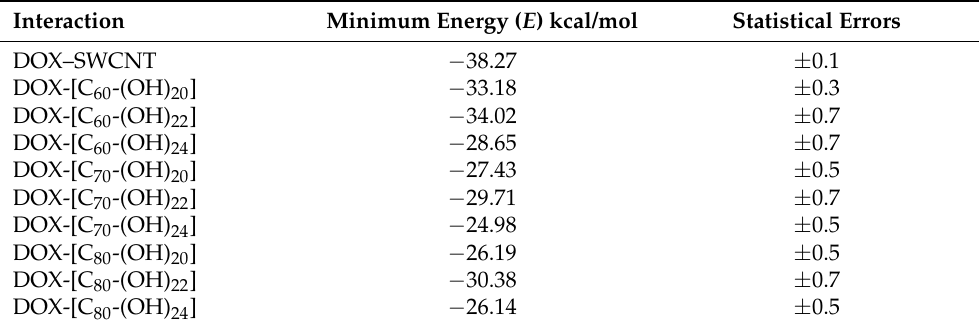
Table 4. The interaction energy ( E ) arising from each configuration interacting with SWCNT and fullerene